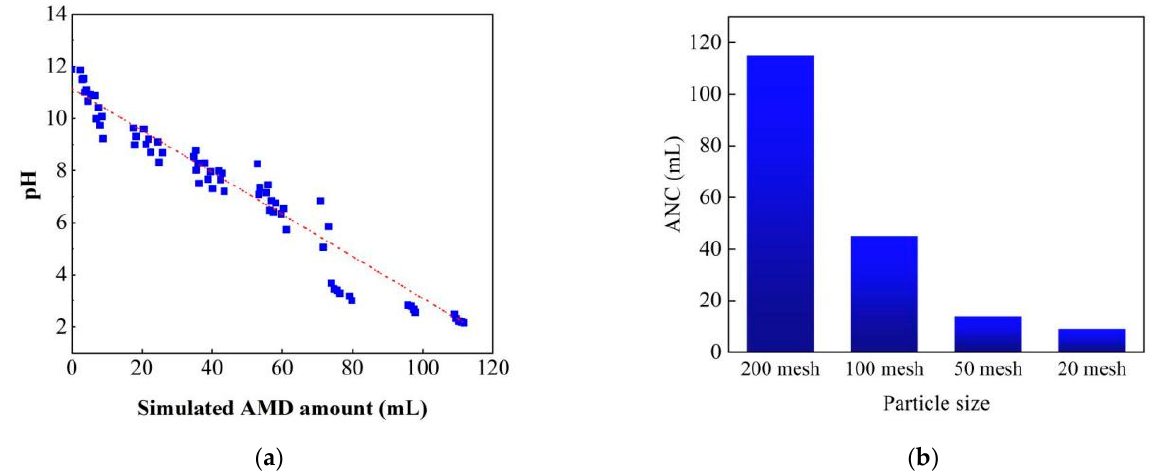
Figure 3. ANC determination results, ( a ) pH variations with simulated AMD; ( b ) influence of particle sizes on slag ANC.